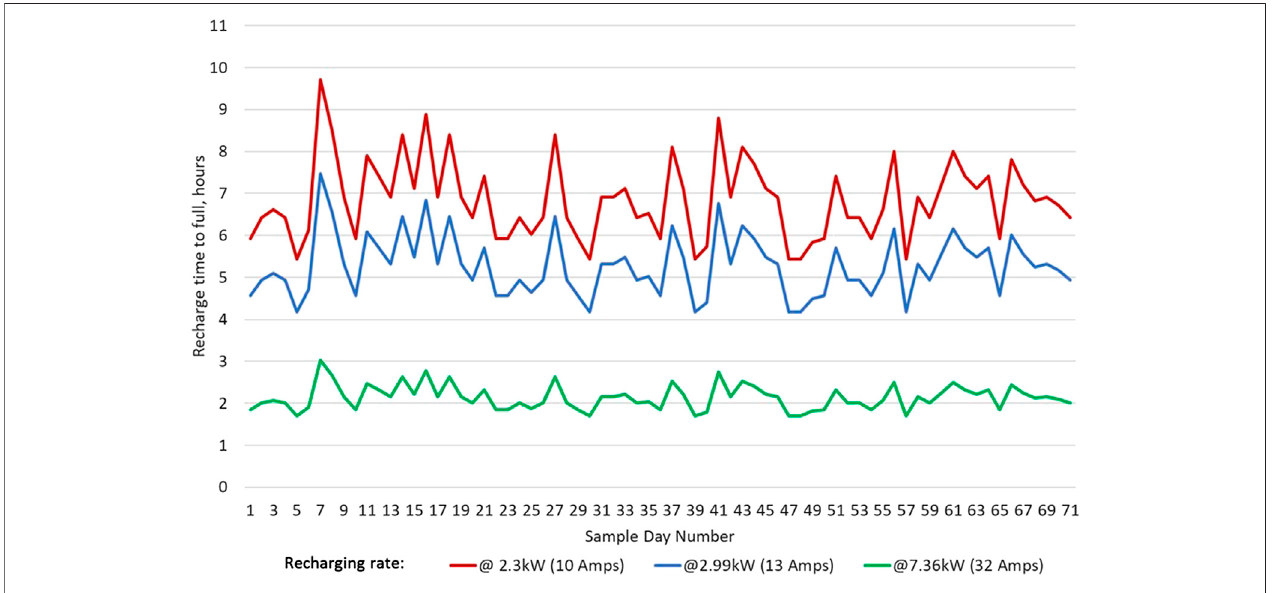
FIGURE 2 | Comparison of recharging time needed to fully re fi ll the battery following each day ’ s shift using different charging rates.